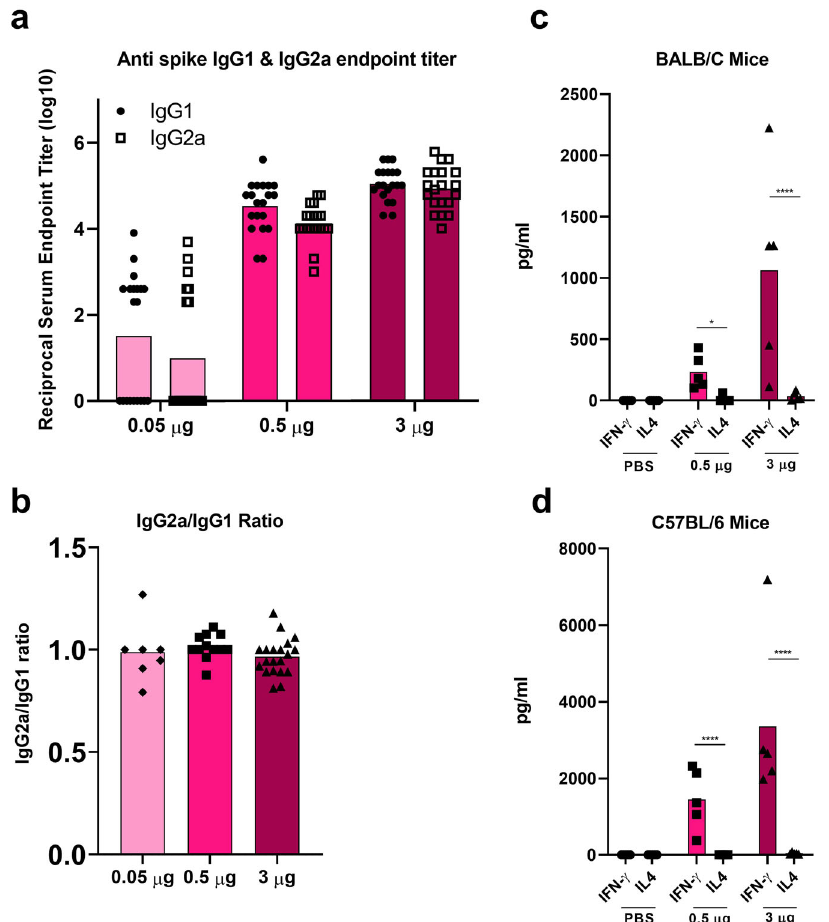
Fig. 4 Predominantly Th1-skewed T cell responses by COReNAPCIN ® . Mice were i.m. injected at days 0 and 21 with 0.05 (light pink), 0.5 (pink) or 3 µg (purple) of COReNAPCIN ® or PBS (gray) and the following assays were conducted, 21 days after the booster injection. a , b Sera from COReNAPCIN ® vaccinated BALB/c mice ( n = 20 each group) tested for SARS-CoV-2 Spike-speci fi c IgG1 (circle shape symbol, ● ) as well as SARS-CoV-2 Spike-speci fi c IgG2a (square shape symbol, □ ) by ELISA ( a ) and endpoint titer ratios of IgG2a to IgG1 were calculated ( b ). c , d Splenocytes from BALB/c and C57BL/6 mice ( n = 5 each group) were exposed to SARS-CoV-2 Spike peptide pool for 24 h and the level of IFN- γ and IL-4 cytokines in the cell culture supernatants were determined through ELISA. Each data point is shown, the height of bars in ( a ) and ( b – d ), respectively, represents the geometric mean and mean. For comparing values between two groups, t -test was conducted and Group comparisons were made by one-way ANOVA followed by Dunn ’ s test. A p value less than 0.05 (* P < 0.05, **** P < 0.0001) was assumed to be statistically signi fi